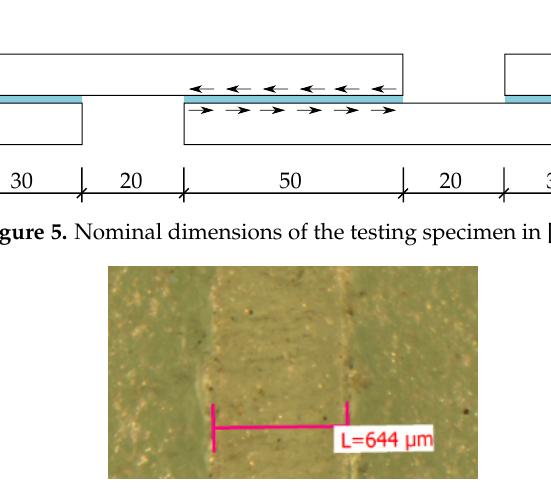
Figure 6. Measured EVA interlayer representative